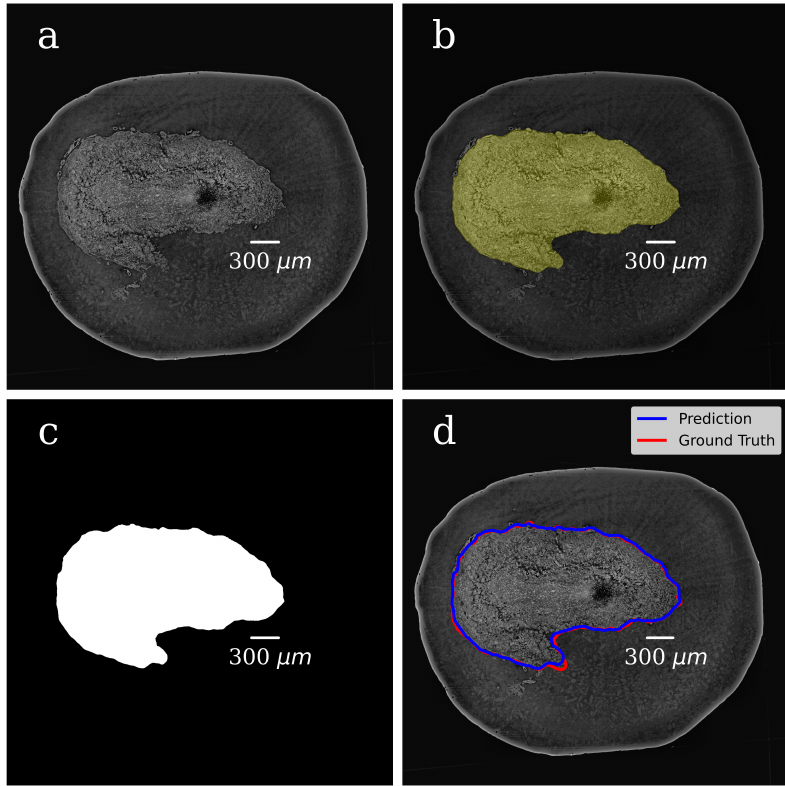
Figure 4. Foreground–background segmentation. ( a ) Grayscale image of the OB tomographic slice; ( b ) foreground/background mask manually annotated in the first step of segmentation, foreground (OB) is marked with greenish color, the background is the rest of the image (paraffin and area); ( c ) CNN generated mask (the U-Net model). The foreground is white, and the background is black; ( d ) grayscale slice image with OB is outlined in red with ground-truth mask (manual segmentation) and in blue with CNN generated mask (the U-Net